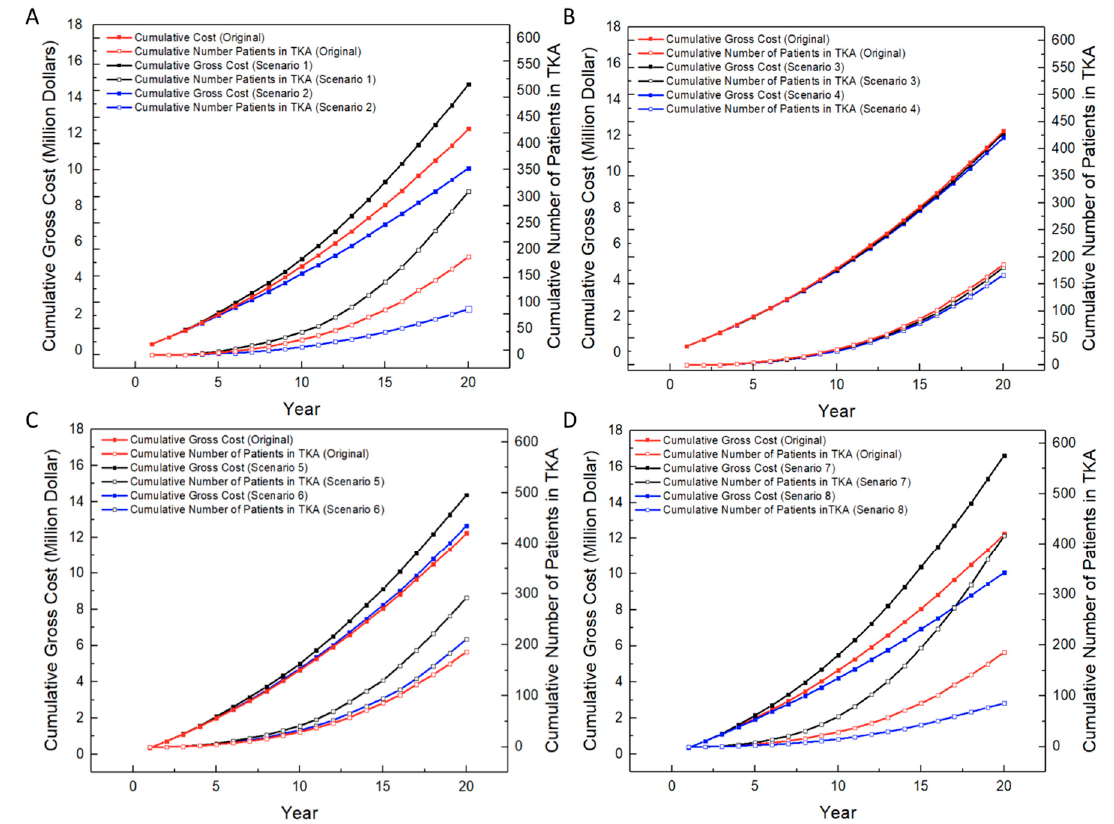
Figure 5. Sensitivity analysis on 3DP-enabled meniscus transplantation: ( A ) Effect of mechanical performance, ( B ) Effect of shape fidelity, ( C ) Effect of biocompatibility, and ( D ) Simultaneous effect of mechanical performance, shape fidelity and biocompatibility.